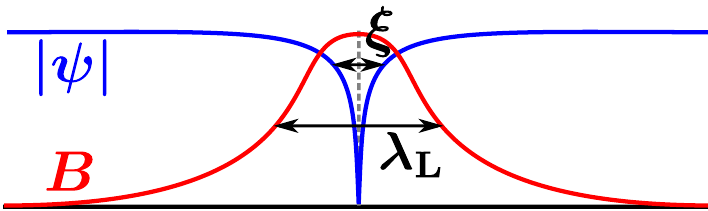
Figure 7.1: Cross section of a vortex in a superconductor. The amplitude of the order parameter field | ψ | falls to zero at the core with the coherence length ξ = while the magnetic field B can penetrate the superconductor up to the London pen- etration depth λ from the L